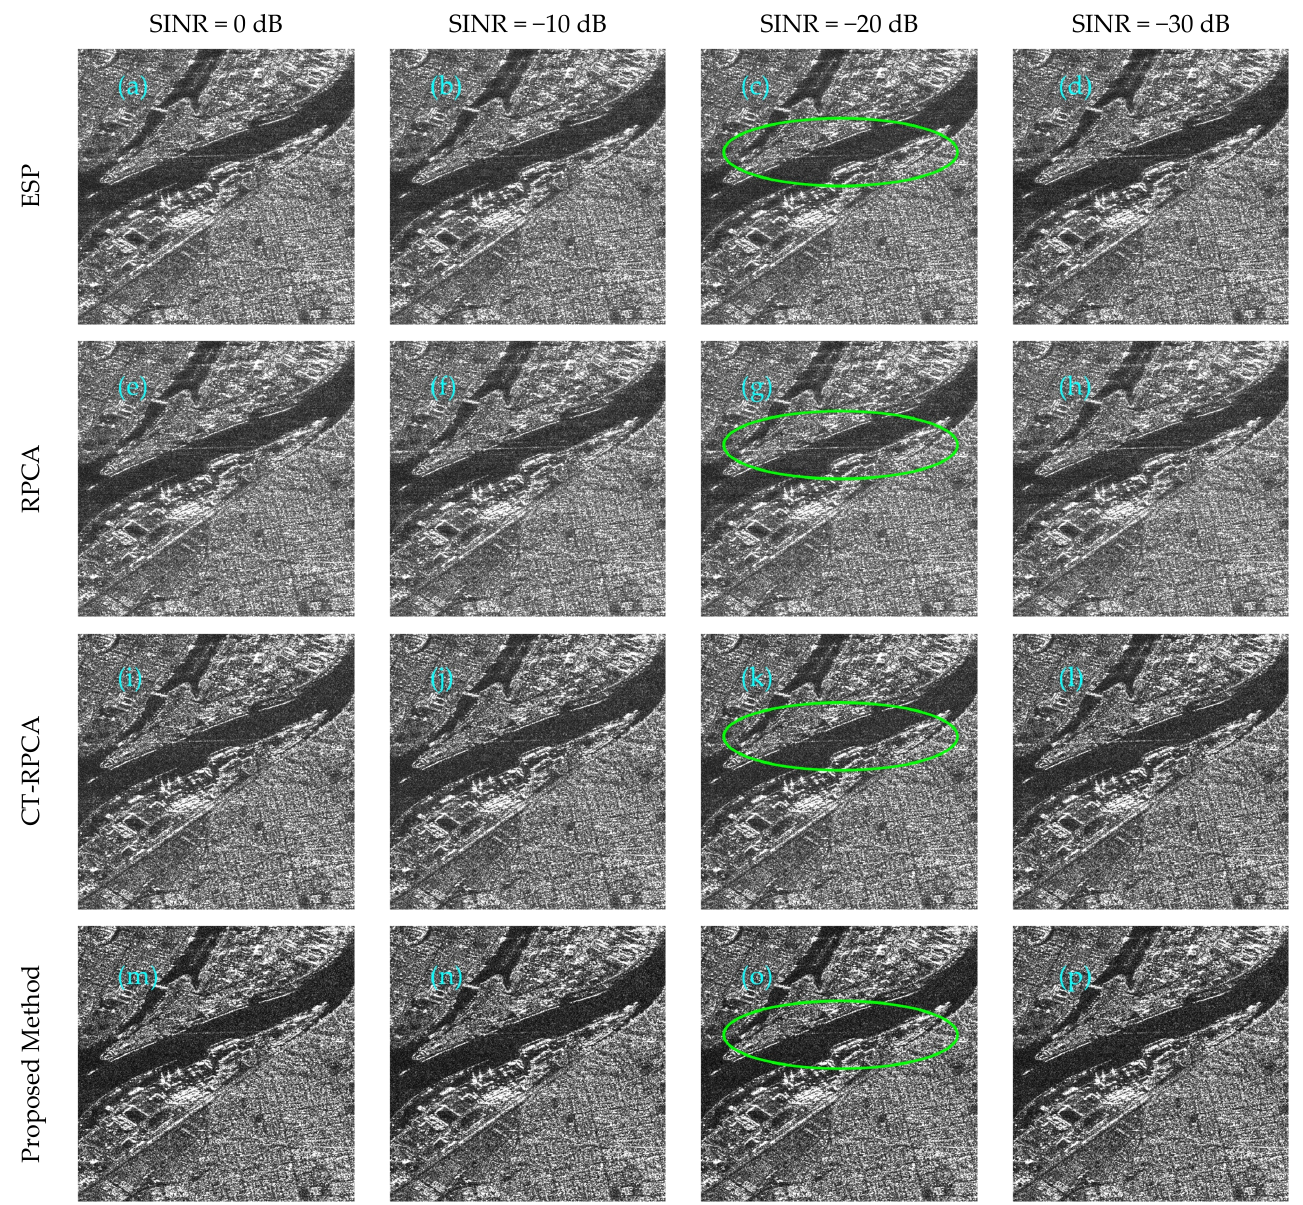
Figure 7. ROIs in Figure 6. ( a – d ) Mitigation results for the ESP method. ( e – h ) Mitigation results for the RPCA method. ( i – l ) Mitigation results for the CT-RPCA method. ( m – p ) Mitigation results for the proposed approach. Table 2. Evaluation metrics for the four methods in the different SINR cases.